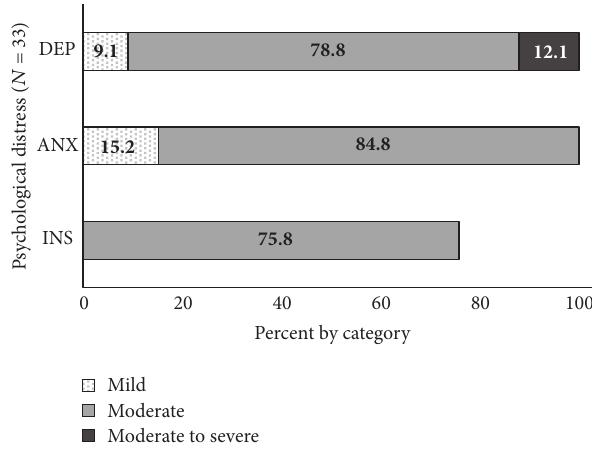
Figure 2: Level of depression, anxiety, and insomnia by category. DEP = depression; ANX = anxiety; INS =